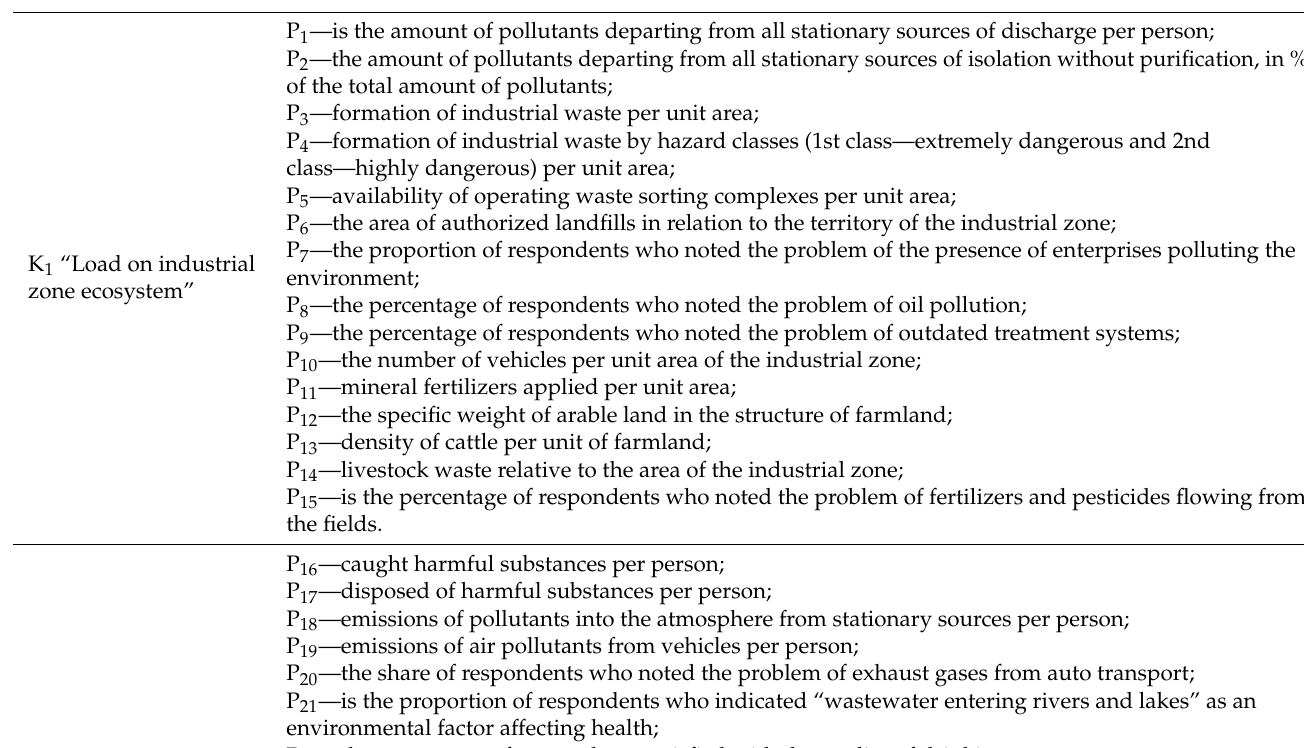
Table 1. Base of partial indicators for the formation of criteria for environmental sustainability of industrial